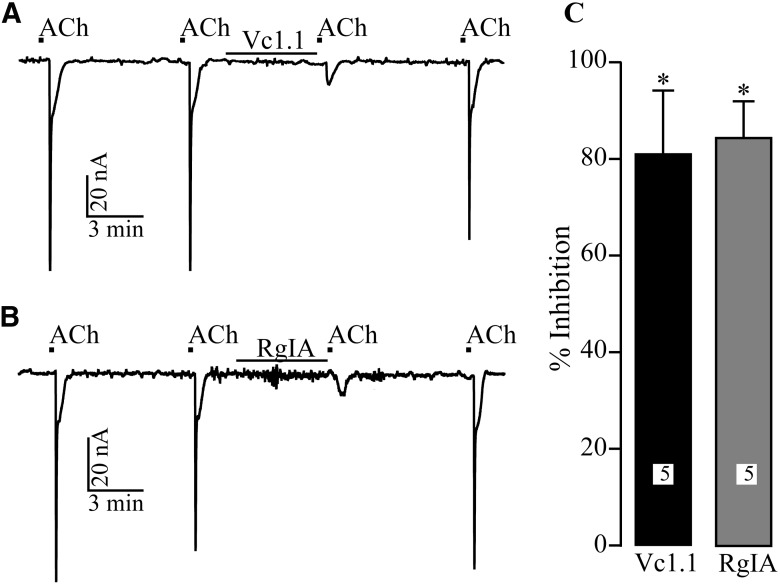
Vc1.1 and RgIA potently block α9α10 nAChRs expressed in X. laevis oocytes. ACh-induced currents were measured from voltage-clamped oocytes as described in Materials and Methods. A, B, Representative traces of ACh-induced currents in the presence and absence of Vc1.1 or RgIA, respectively. C, The mean (±SD) inhibition of ACh-induced peak current amplitude by α-conopeptides Vc1.1 and RgIA. The numbers in bars reflects numbers of cells tested. * indicates significant inhibition (p < 0.05).